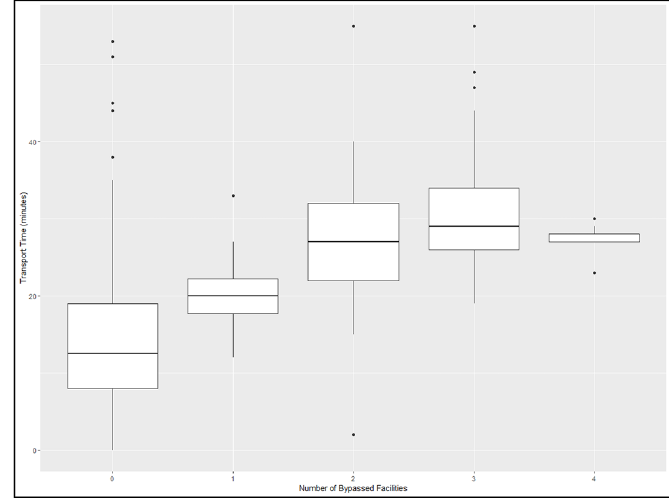
Figure 1. Actual transport time by number of bypasses per route. Box and whisker plots represent median (middle line), IQR (borders of box from 25th (Q1) to 75th (Q3) percentiles), edges of lines represent values within Q1 – 1.5*IQR to Q3 + 1.5*IQR; isolated dots represent outliers beyond the ±1.5*IQR values. IQR , interquartile